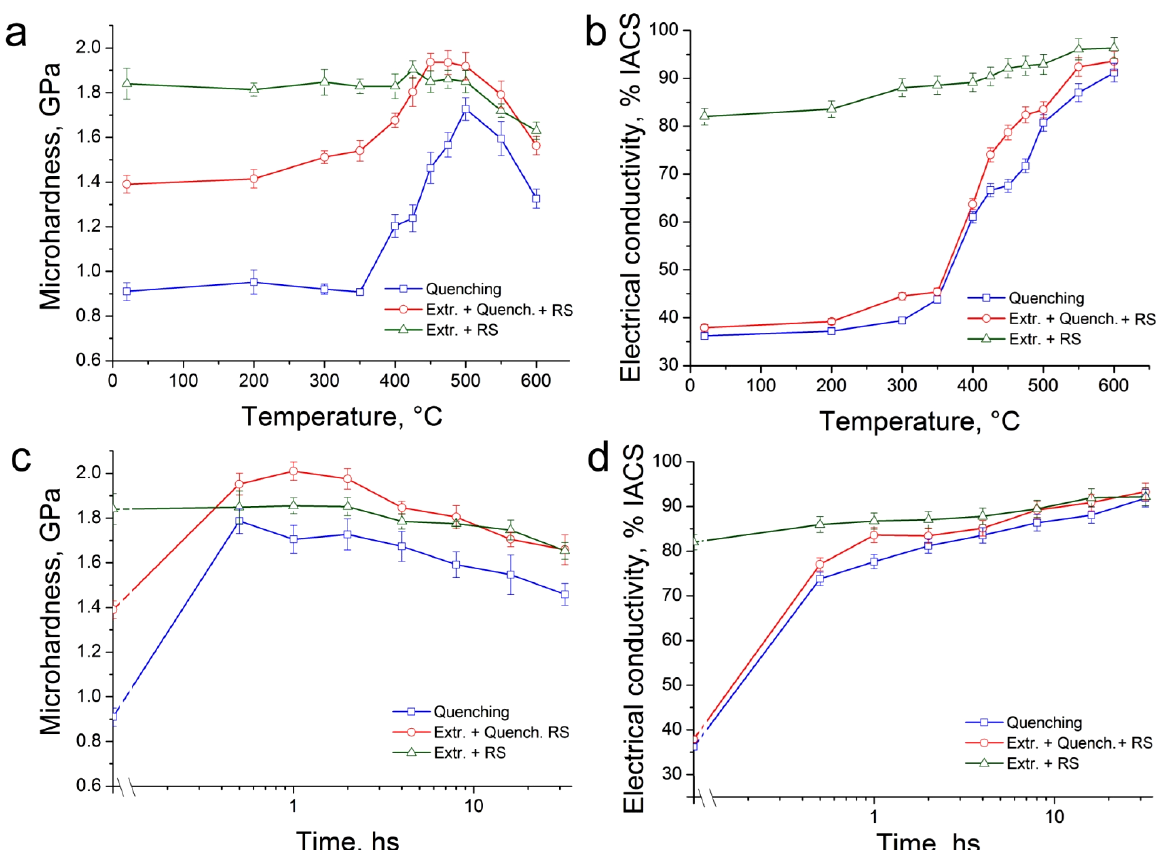
Figure 4. Dependence of microhardness ( a , c ) and electrical conductivity ( b , d ) of Cu-0.5%Cr-0.08%Zr alloy in various states on temperature ( a , b ) and time ( c , d ) of heating.